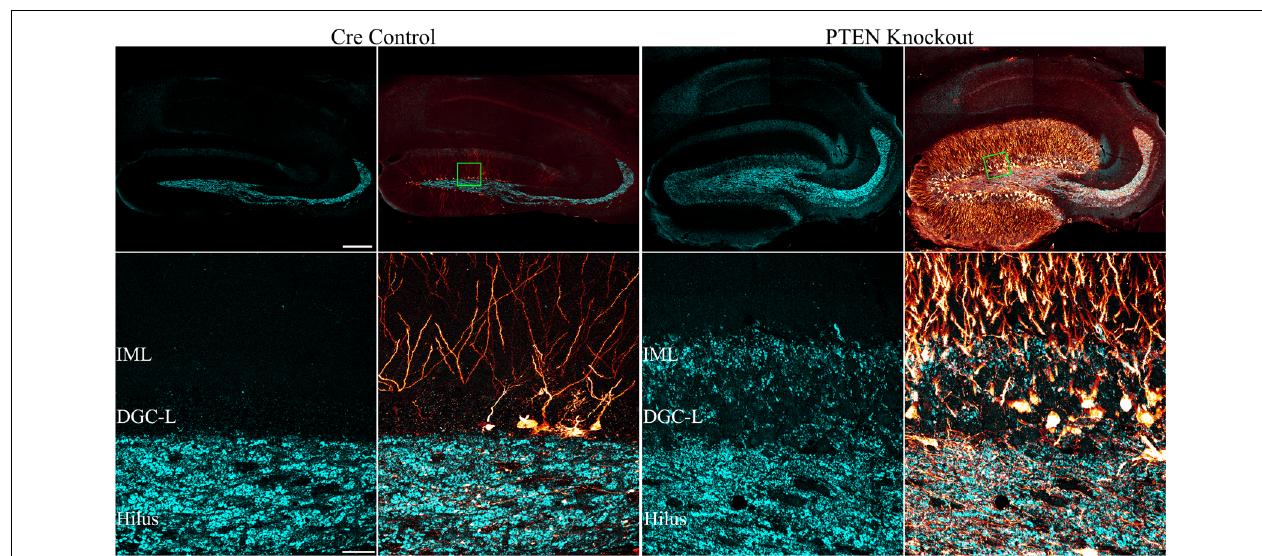
lucidum) in the control animal, while mossy fiber sprouting into the dentate granule cell layer (DGC-L) and inner molecular layer (IML) is evident in the knockout animal (green boxes in the top row correspond to high resolution images shown in the bottom row). Scale bars = 200 μ m (top row) and 30 μ m (bottom row). Reprinted with permission from Pun etal.